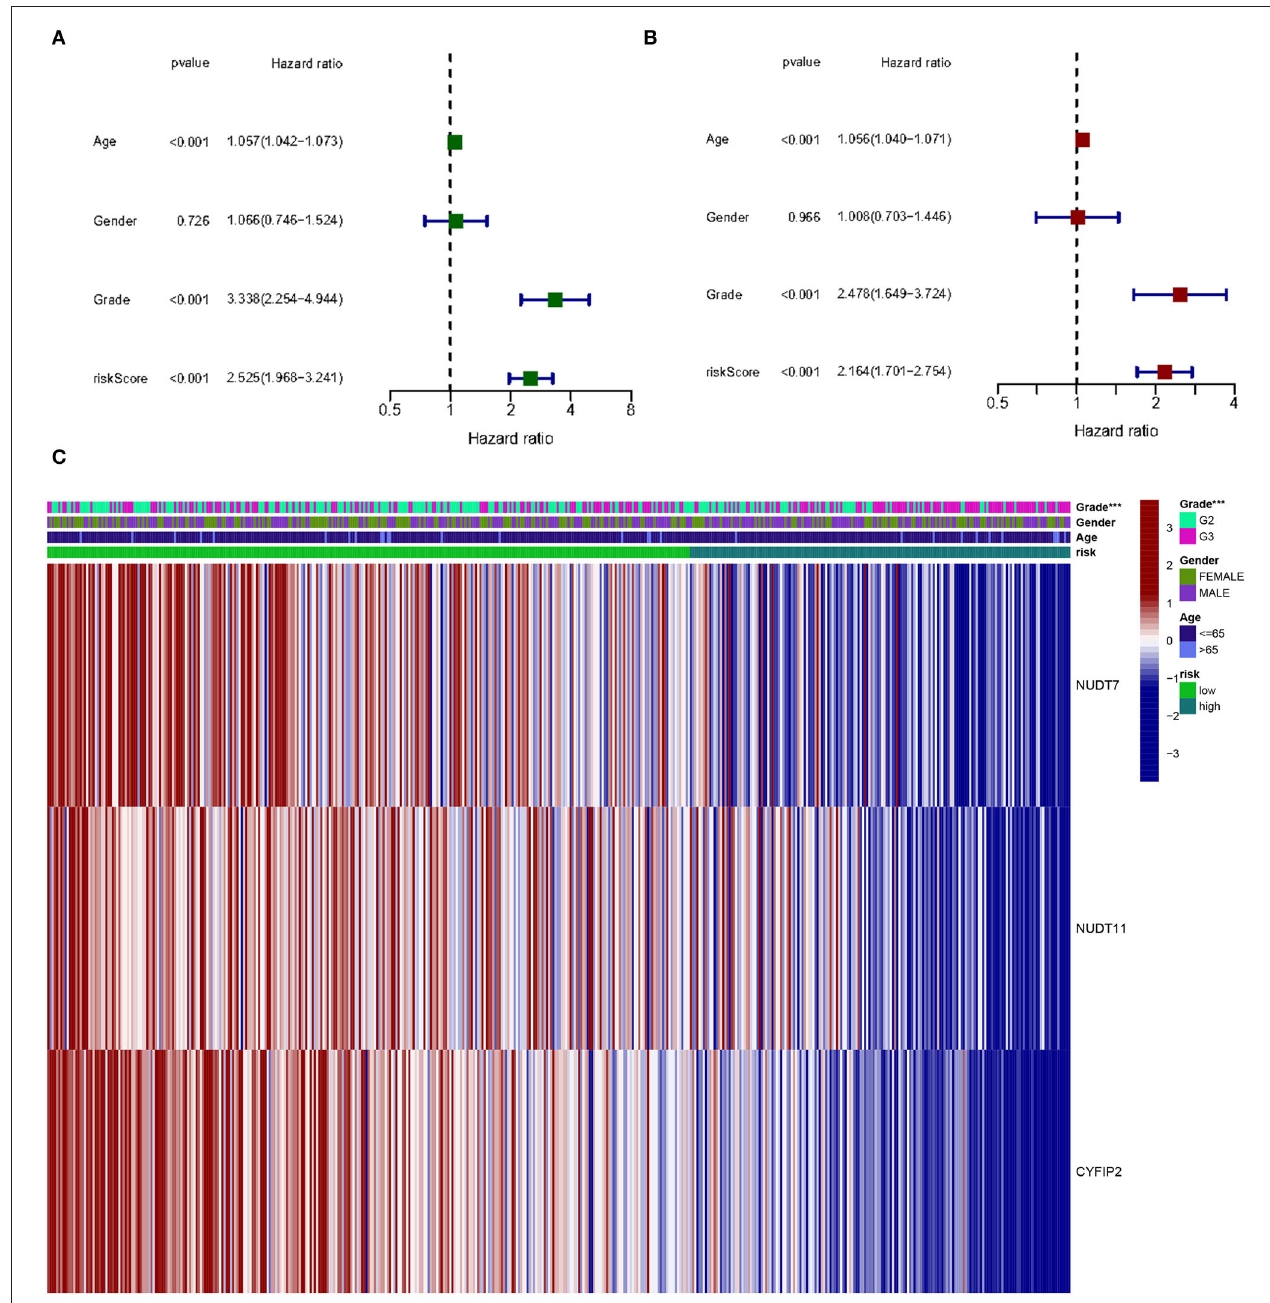
FIGURE 8 | The effect of a risk score on the prognosis of patients with gliomas. (A) Univariate Cox regression analysis of three-gene risk score, age, and grade. (B) Multivariate Cox regression analysis of three-gene risk score, age, and grade (*** p < 0.001). (C) Heat map shows the distribution of the expression of three m7G RNA-modifying regulators and clinicopathological features in high- and low-risk